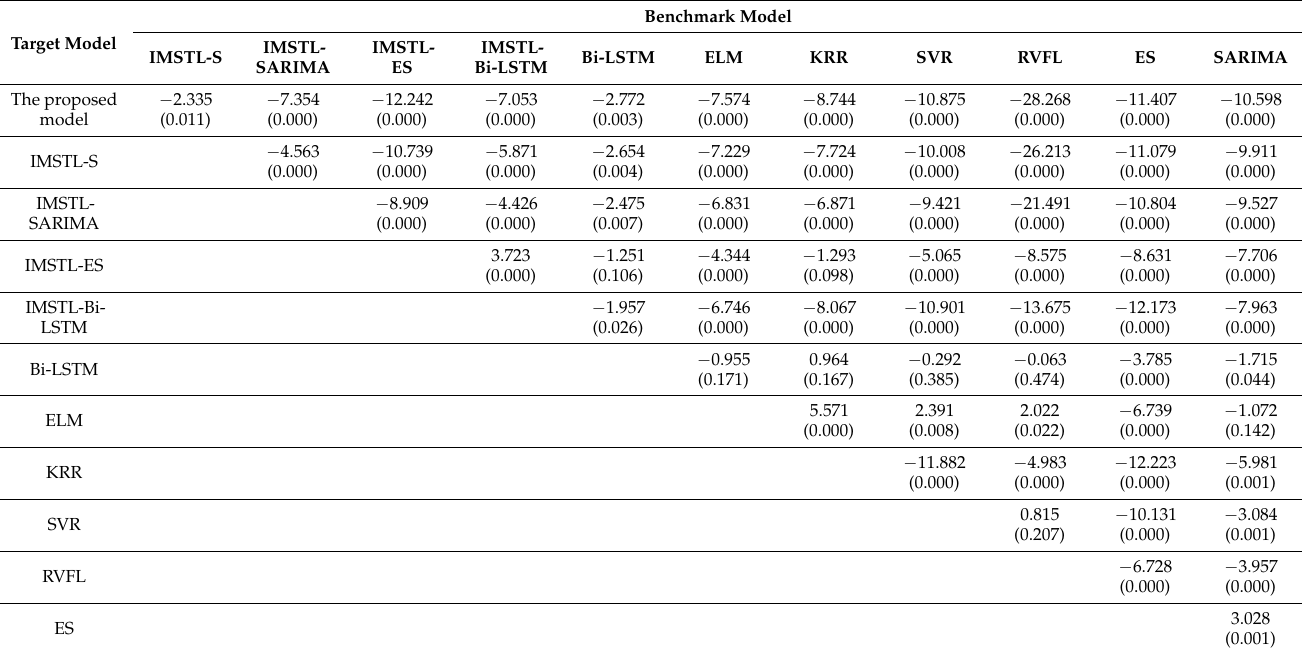
Table 7. Results of the DM test.